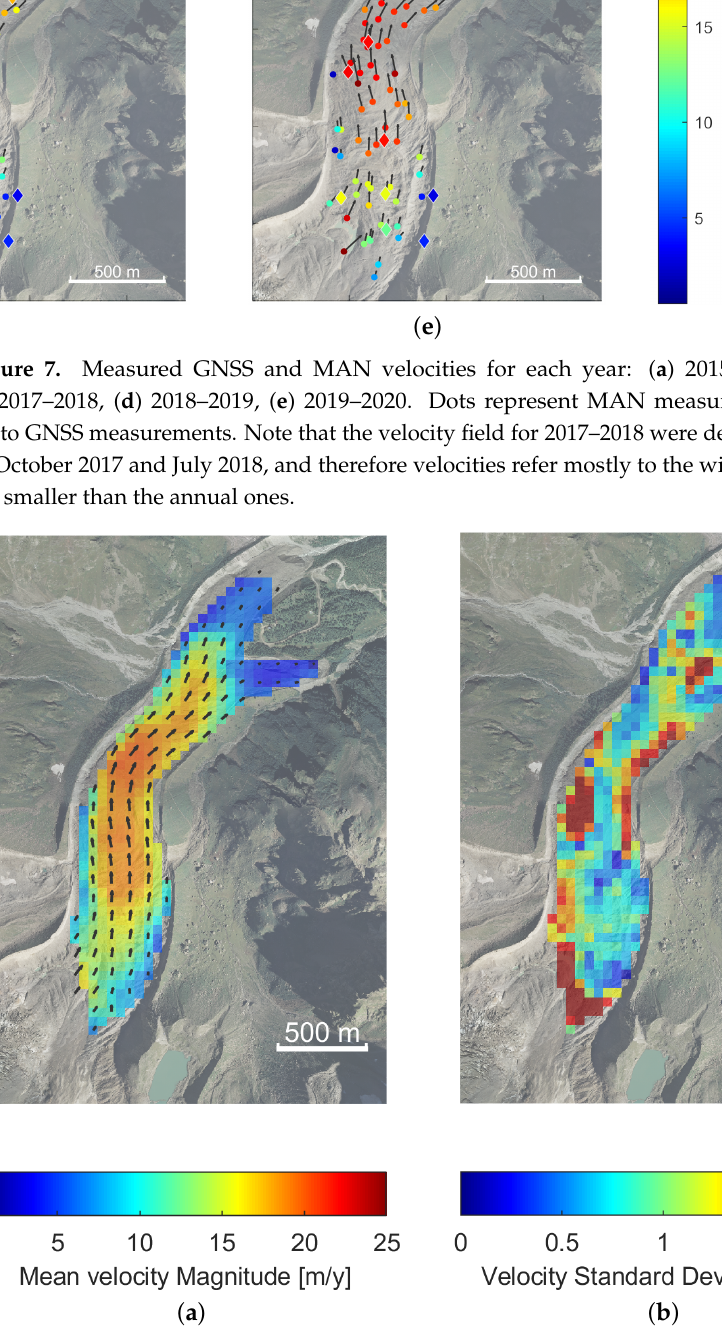
Figure 8. ( a ) Mean surface velocity field of the Belvedere Glacier for the period 2015–2020. ( b ) Standard deviation of the velocity time-series (2015–2020) for each cell of the raster grid. Note that in both ( a , b ), year 2017–2018 was not